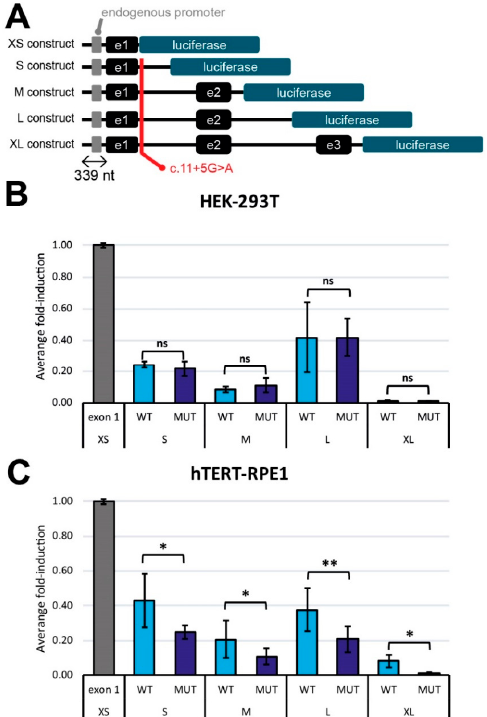
Figure 7. Expression analysis using luciferase assays. ( A ) Schematic representation of the different luciferase constructs and the position of the c.11+5G>A mutation. All constructs contain the 339 nt upstream region from the exon 1. ( B , C ) are a comparison of the average fold-induction between the wildtype transcripts (WT) and the ones harboring the mutation (MUT) in HEK-293T ( B ) and hTERT- RPE1 ( C ) (n = 4). Each bar represents the mean value in percentage ± SD. Statistical differences with respect the negative control (XS construct) by one-way ANOVA test are indicated as * p < 0.05 and ** p < 0.01 or ns: not-significant.